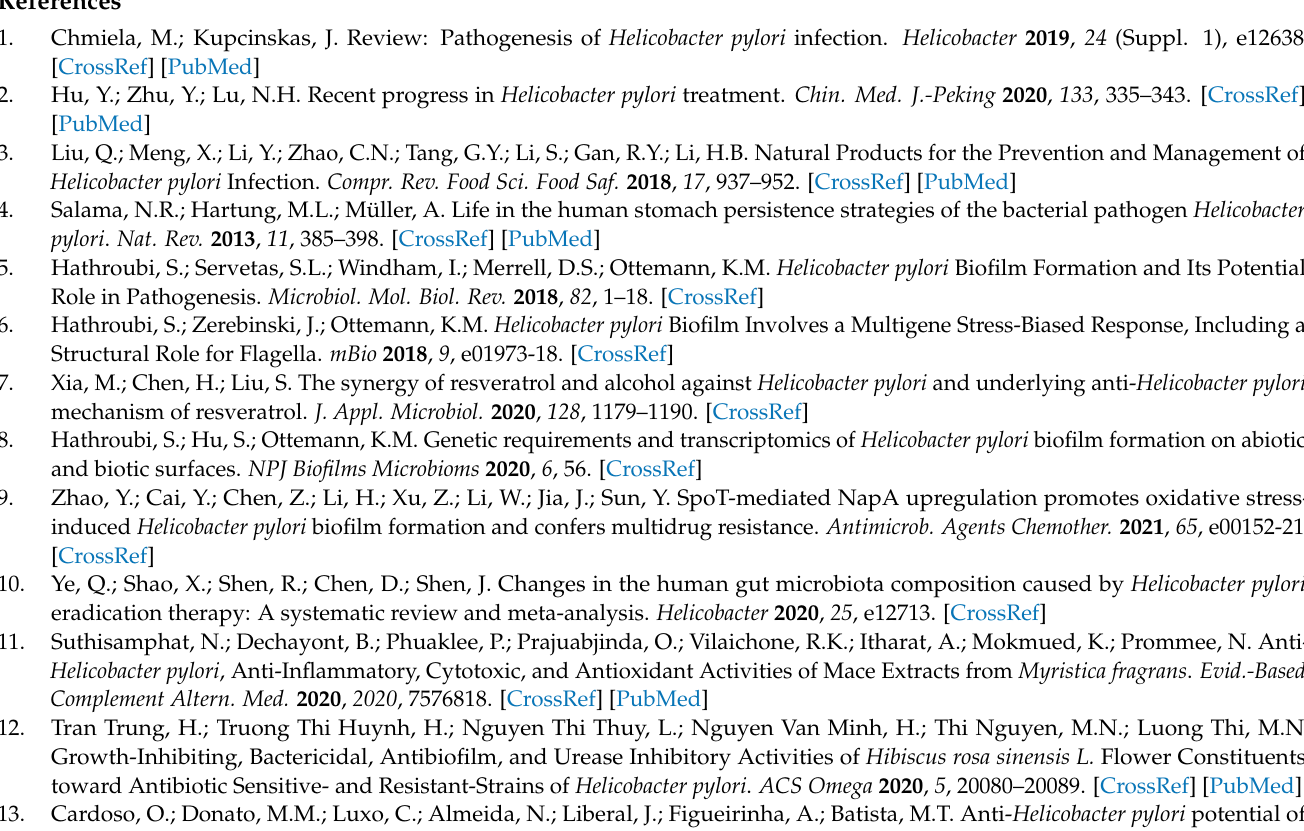
pression pattern, Supplementary Figure S2: Volcano plot, Supplementary Table S1: RNA sample quality results, Supplementary Table S2: Top KEGG pathway ( p < 0.1) in CF7 and CF9, Supplemen- tary Table S3: The top 20 up- and downregulated genes in CF7 and CF9, Supplementary Table S4: Real-time PCR